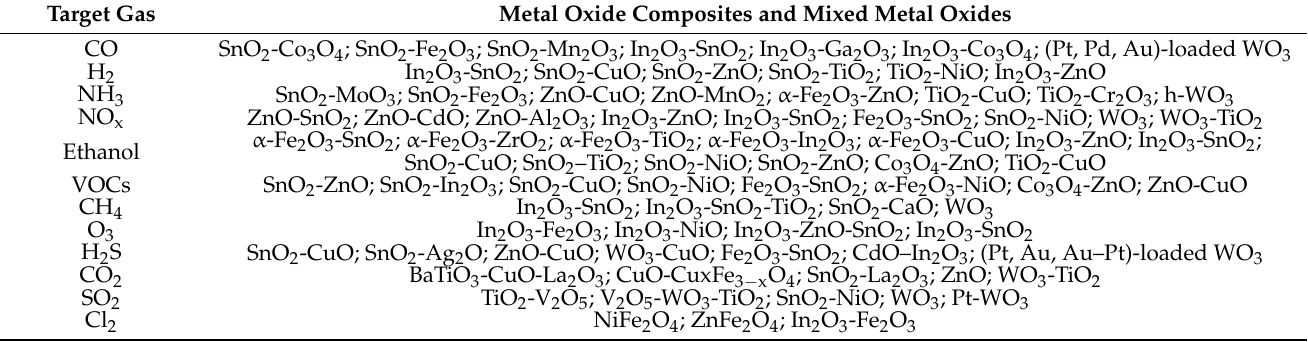
Table 5. Metal oxides for application in gas sensors. Elaboration from Refs.